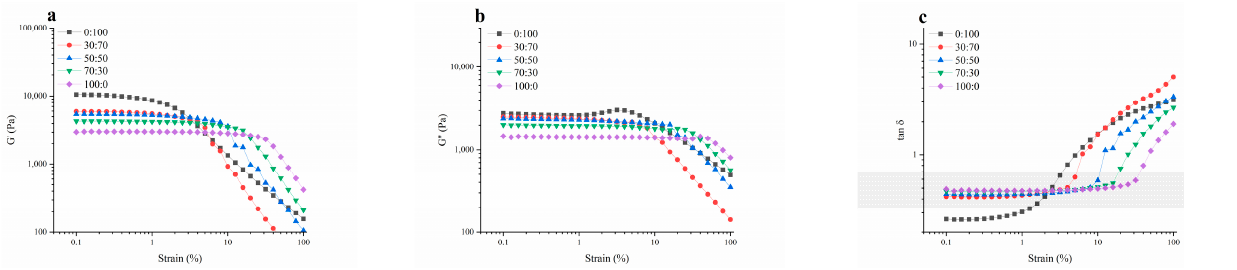
Figure 3. The changes in energy storage modulus G ′ ( a ), energy loss modulus G ″ ( b ), and tan δ ( c ) of di ff erent raw material–water mixtures under frequency sweep.